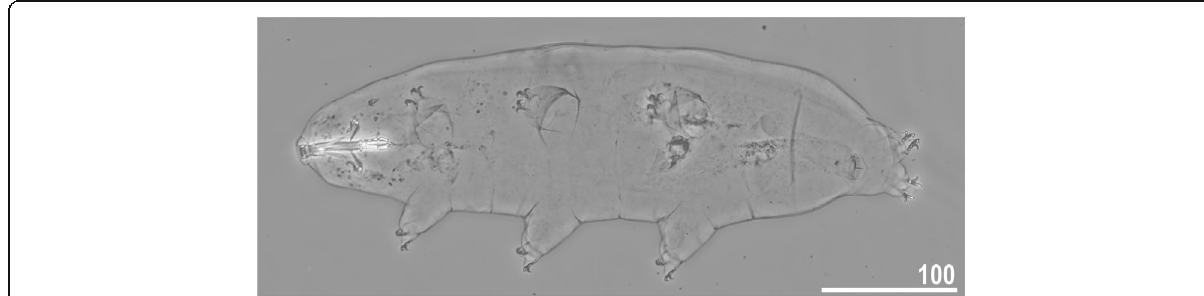
Fig. 30 Macrobiotus margoae sp. nov. from the USA (US.057) – habitus, adult specimen in dorsoventral projection (holotype). Scale bar in μ m